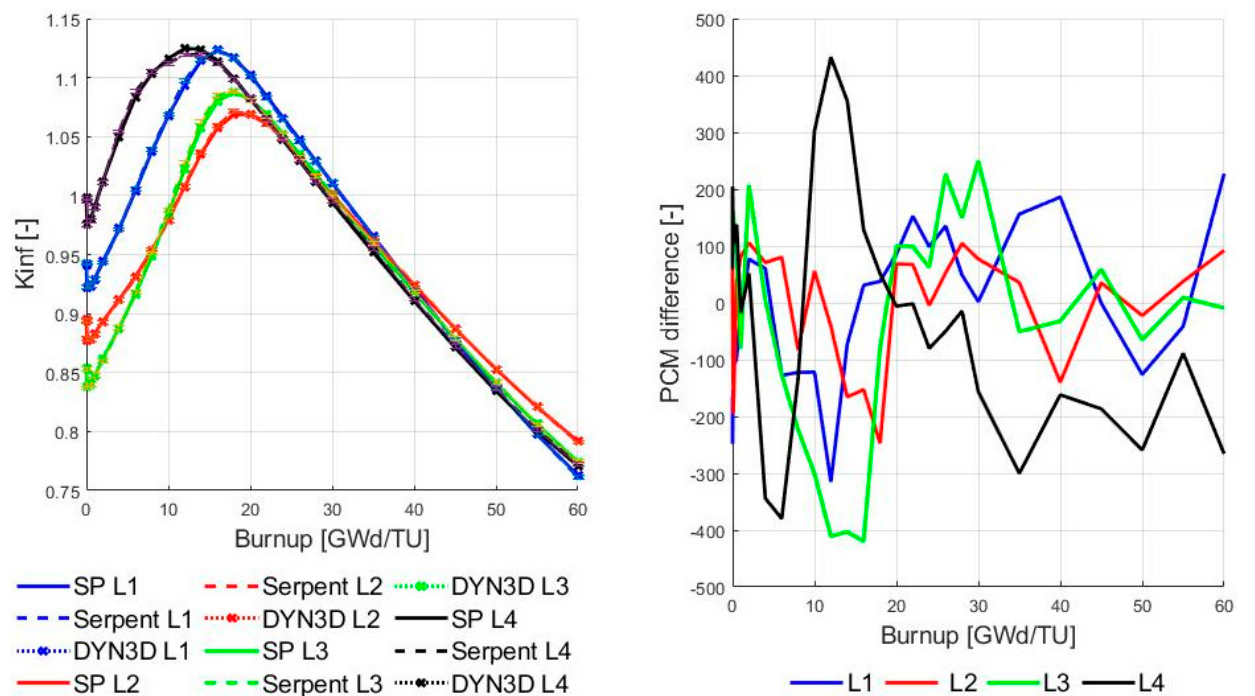
Figure 6. Left : k inf over burnup of assembly one in full power operation up until 60 GWd/TU comparing Scale-Polaris (SP), DYN3D and Serpent. Right : The PCM variation at each burnup stage (SP ‐ Serpent).